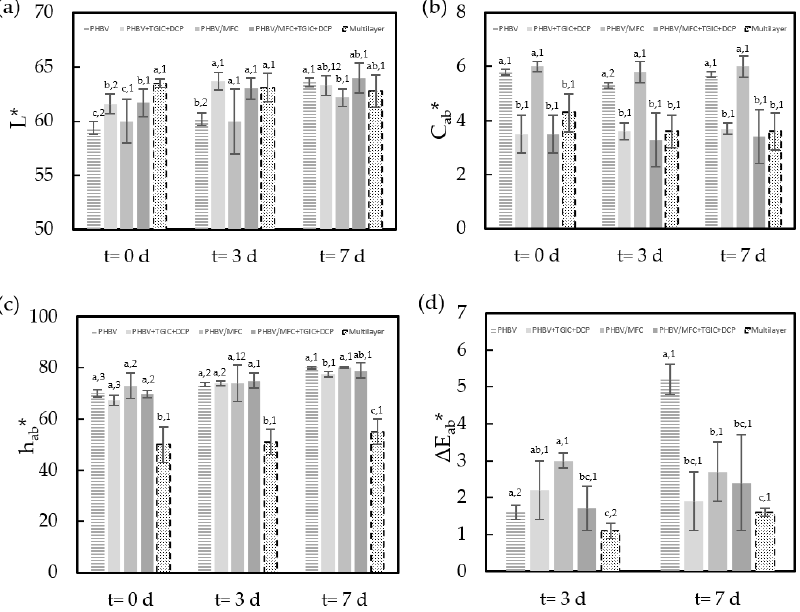
Figure 3. Development of color parameters in terms of ( a ) lightness ( L* ), ( b ) chroma ( C ab * ), ( c ) hue ( h ab * ), and ( d ) total color difference (Δ E ab * ) of the cold-stored minced pork meat samples packaged in trays with the green composite lid films of poly(3-hydroxybutyrate- co -3-hydroxyvalerate) (PHBV) with microfibrillated cellulose (MFC) and compatibilized with triglycidyl isocyanurate (TGIC) and dicumyl peroxide (DCP) and the multilayer commercial film. Color parameters of each film reported in previous studies * [18] and ** [21]: L* (PHBV (88.41 ± 0.11)*; PHBV + TGIC + DCP (89.39 ± 0.15)*;